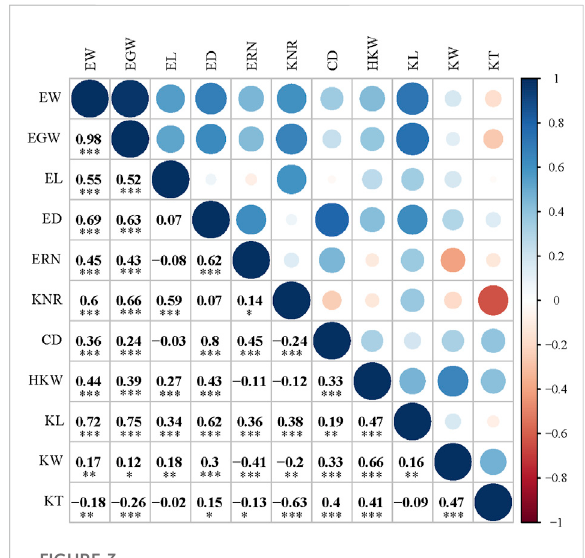
FIGURE 3 Pearson correlation coef fi cients for the BLUP value of 11 ear traits in 256 maize inbred lines. Abbreviations for traits are as follows: CD, core diameter; ED, ear diameter; EGW, ear grain weight; EL, ear length; ERN, ear row number; EW, ear weight; HKW, hundred kernel weight; KNR, kernel number per row; KW, kernel width. * indicates a statistical signi fi cance at p < 0.05 level, ** indicates a statistical signi fi cance at p < 0.01 level, *** indicates statistical signi fi cance at p < 0.001